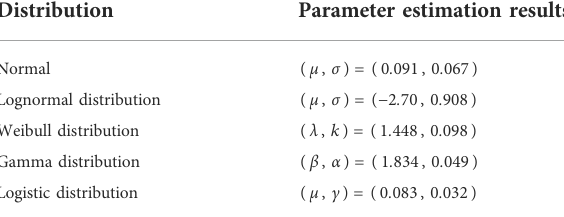
TABLE 4 Parameter estimation results of the distribution